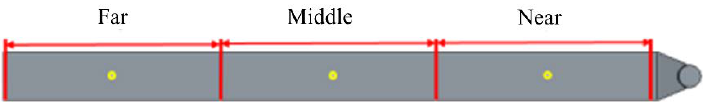
Figure 3. Sensor location for three sections of the